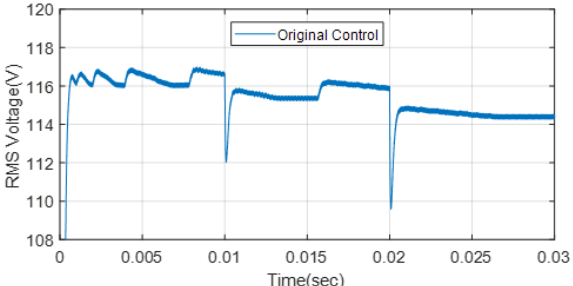
Fig.9: ESU output RMS voltage for original controller.